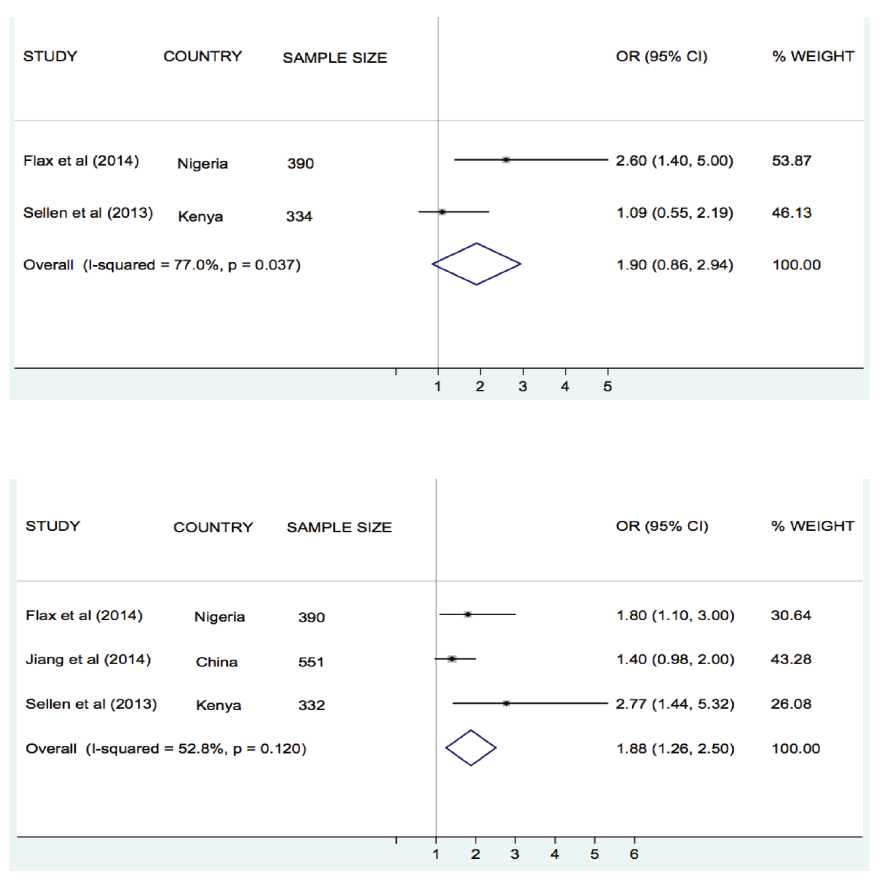
or more antenatal care clinics (OR 2.39, 95% CI 1.03– 5.55) and have skilled attendance at delivery (OR 5.73, 95% CI 1.51–21.81) than those who received routine